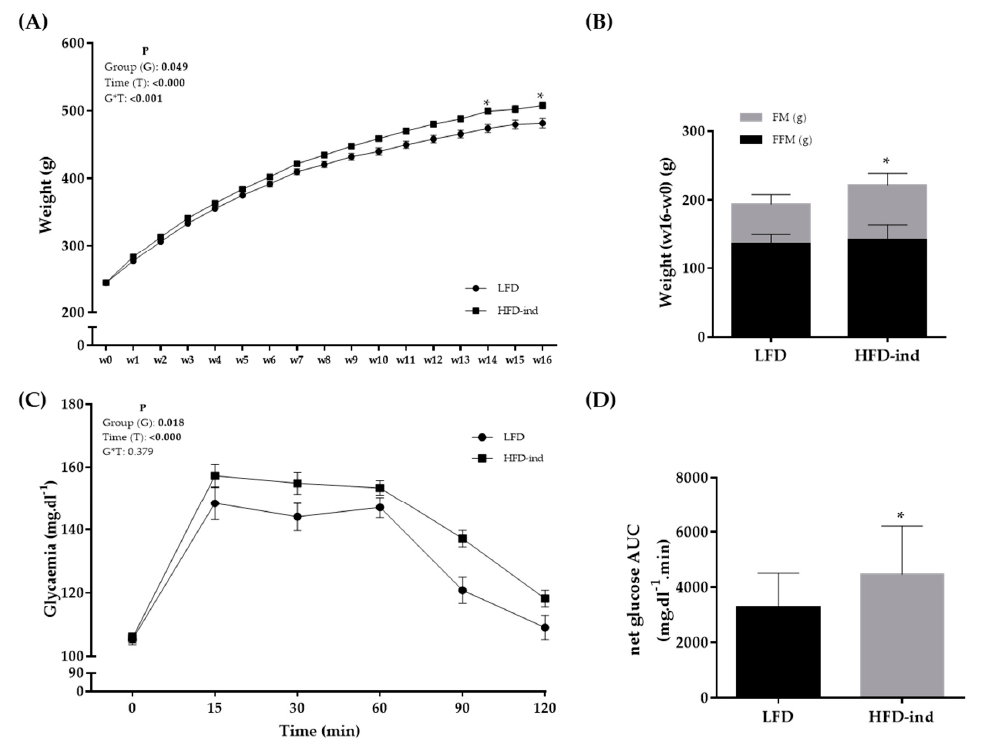
Figure 2. Body composition changes and glycemic profile of the LFD ( n = 12) and HFD ( n = 48) groups at the end of phase 1 (obesity induction with the HFD for 16 weeks). ( A ) Weight (g) monitoring during phase 1. ( B ) Weight, fat mass, and fat-free mass changes (w16 – w0) in the LFD and HFD groups. ( C ) Glycemia monitoring during the oral glucose tolerance test (mg.dl − 1 ). ( D ) NetAUC for glucose (mg.dl − 1 .min) in the LFD and HFD groups. * p < 0.05. LFD: low-fat diet, HFD: high-fat diet, AUC: area under the curve, FM: fat mass, FFM: fat free mass.